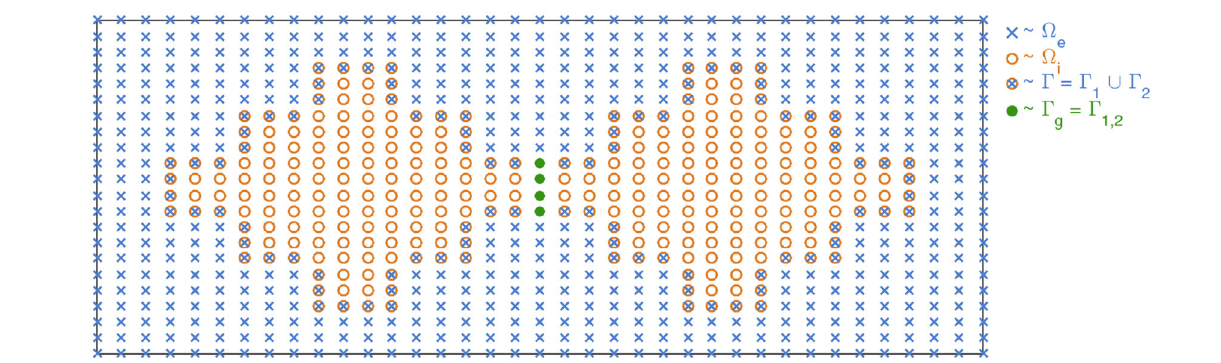
FIGURE 2 | Sketch of the computational mesh used for the FDM. Nodes in (cid:127) e are marked by × , nodes in (cid:127) i = (cid:127) 1 i ∪ (cid:127) 2 i are marked by ◦ , nodes on the membrane between the intracellular and the extracellular space ( Ŵ = Ŵ 1 ∪ Ŵ 2 ) are marked by ⊗ , and nodes on the membrane between two cells ( Ŵ 1,2 ) are marked by • .